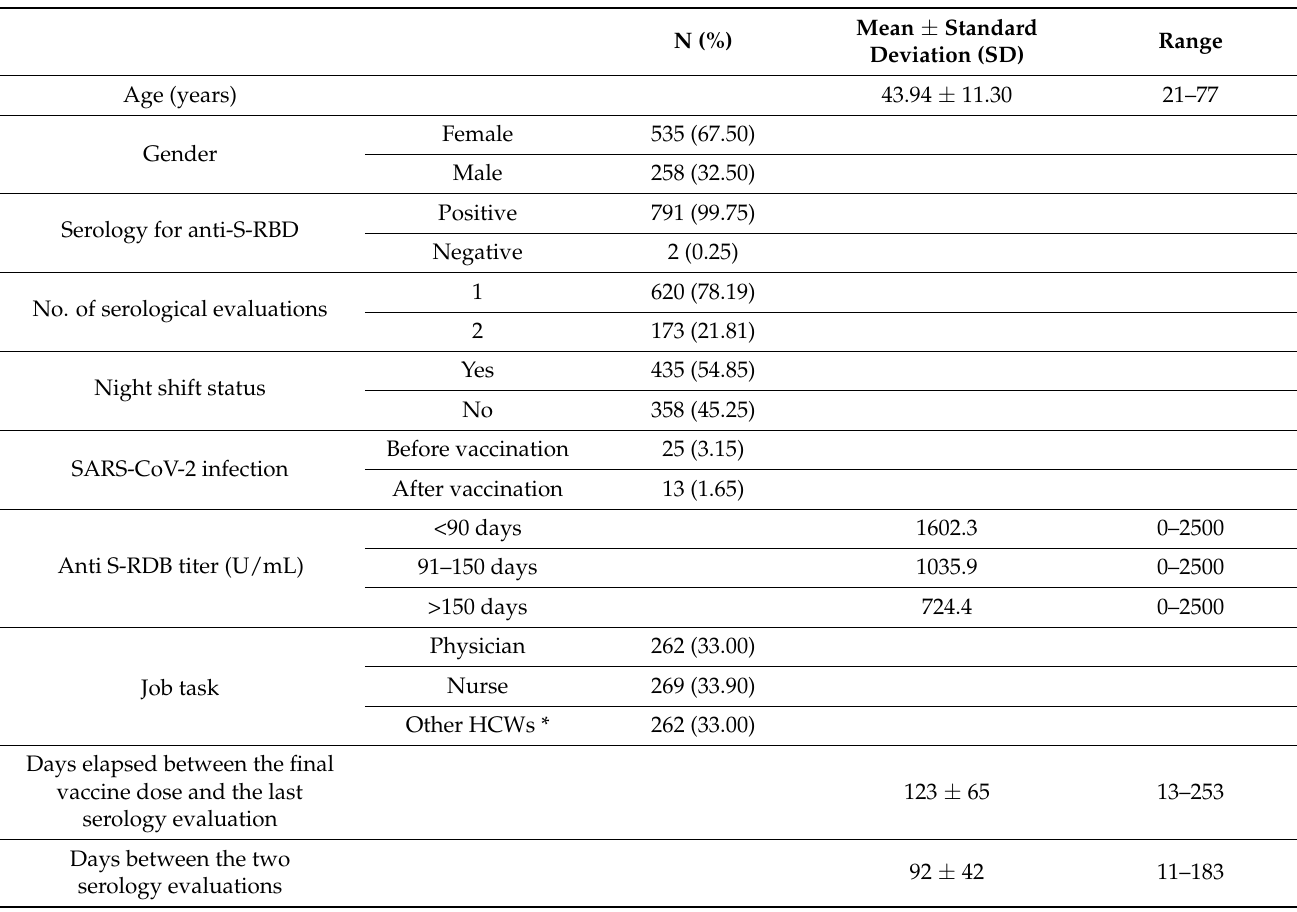
Table 1. Characteristics of the study population including vaccination and serology